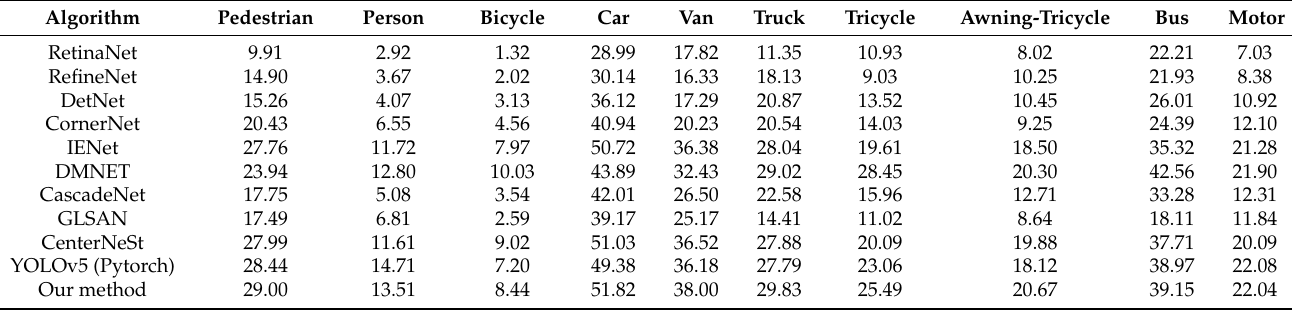
Table 5. Analysis of The AP Scores of Each Object Category in VisDrone-DET2021